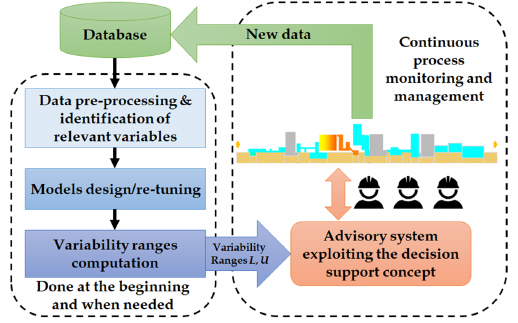
Figure 3. Schematic flow diagram of the proposed approach.